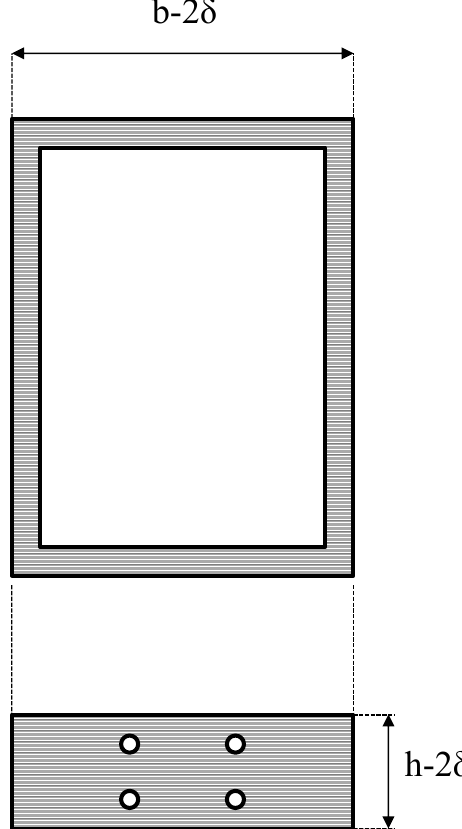
Figure 3. Schematic drawing of the sliding